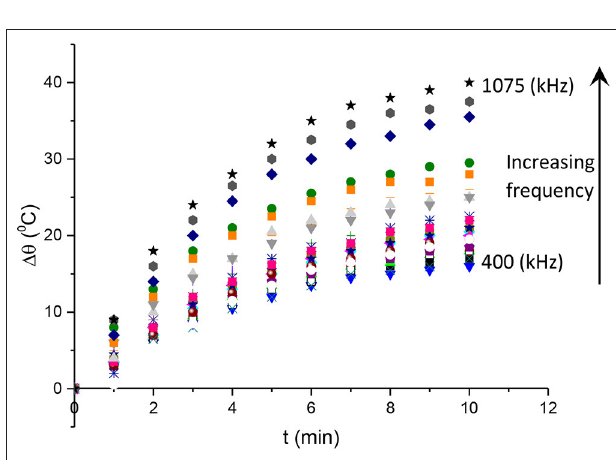
FIGURE 5 | Fitting of Equation 3 in the data of Figure 3 . TABLE 3 | Results of the fit of Equation 3 in the data of Figure 3